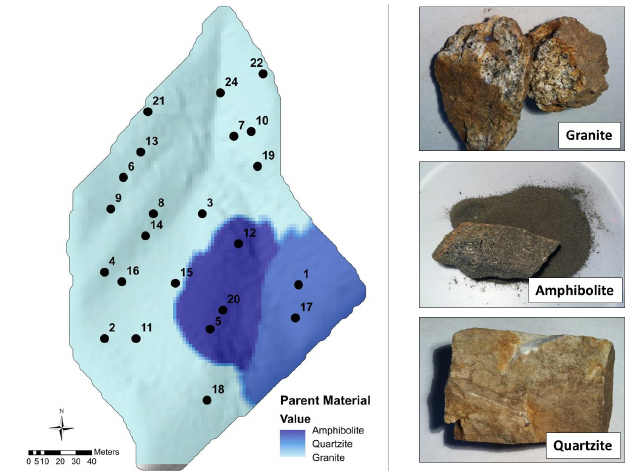
Figure 3. Modeled spatial distribution of parent materials in the study catchment and examples of typical rocks sampled from the soil profiles sampled on each parent material.